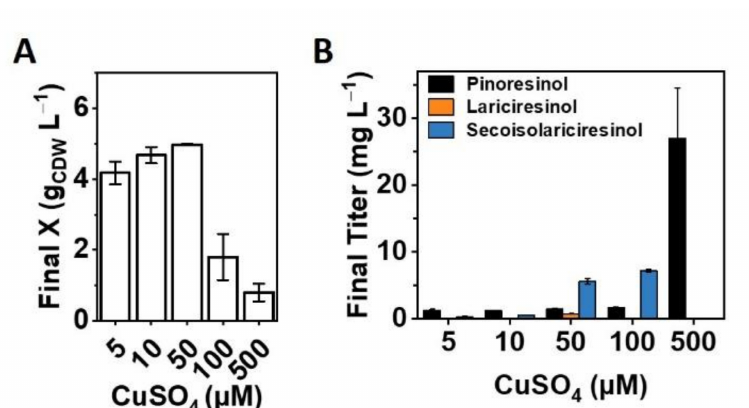
Figure 2. Variation of CuSO 4 concentration for optimization of SILR production. E. coli C43(DE3) pCDFDuet_syfiPLR was cultivated at 37 ◦ C, 180 rpm, in modified Riesenberg medium. At OD 600 0.6, 0.75 mM IPTG, 0.5 g L − 1 coniferyl alcohol, and various CuSO 4 concentrations were added. After induction, the cultivation temperature was reduced to 30 ◦ C. Cultivations were stopped 24 h after induction. ( A ) Final biomass concentrations (X) and ( B ) titers of pinoresinol, lariciresinol, and SILR are displayed in dependency on the supplemented CuSO 4 concentration. CDW: cell dry